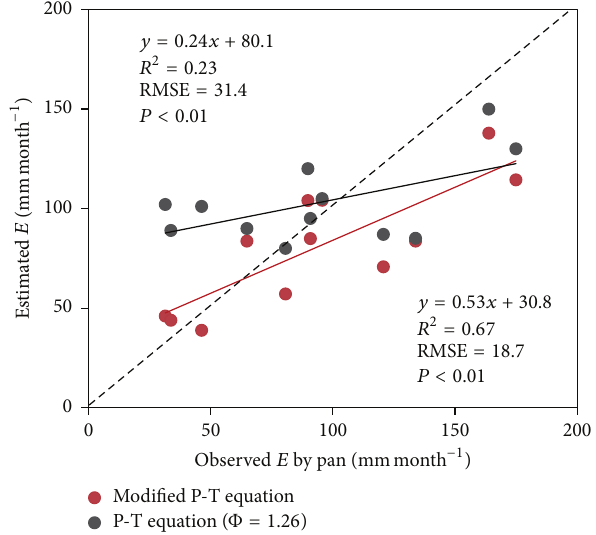
Figure 2: Validation of the estimated water evaporation based on pan evaporation that was conducted at the Tangyin site in 2013.